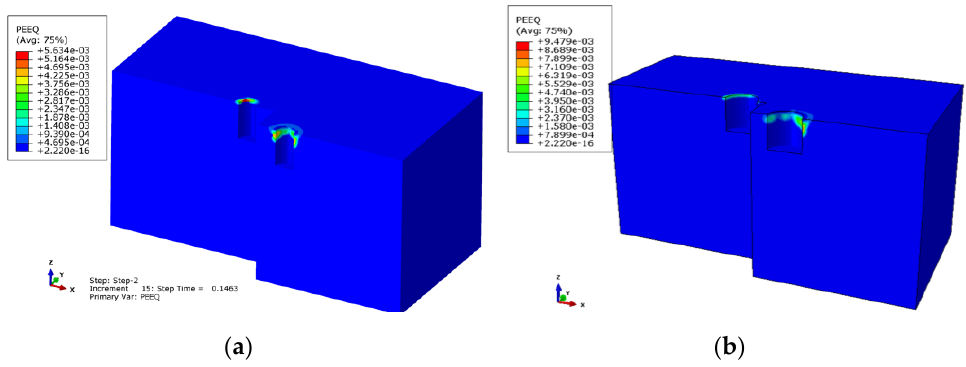
Figure 22. Soil equivalent plastic strain contours at the 1# and 2# bucket central section for the TSPJF and TBJF under the ultimate overturning moment. ( a ) TSPJF, ( b ) TBJF.